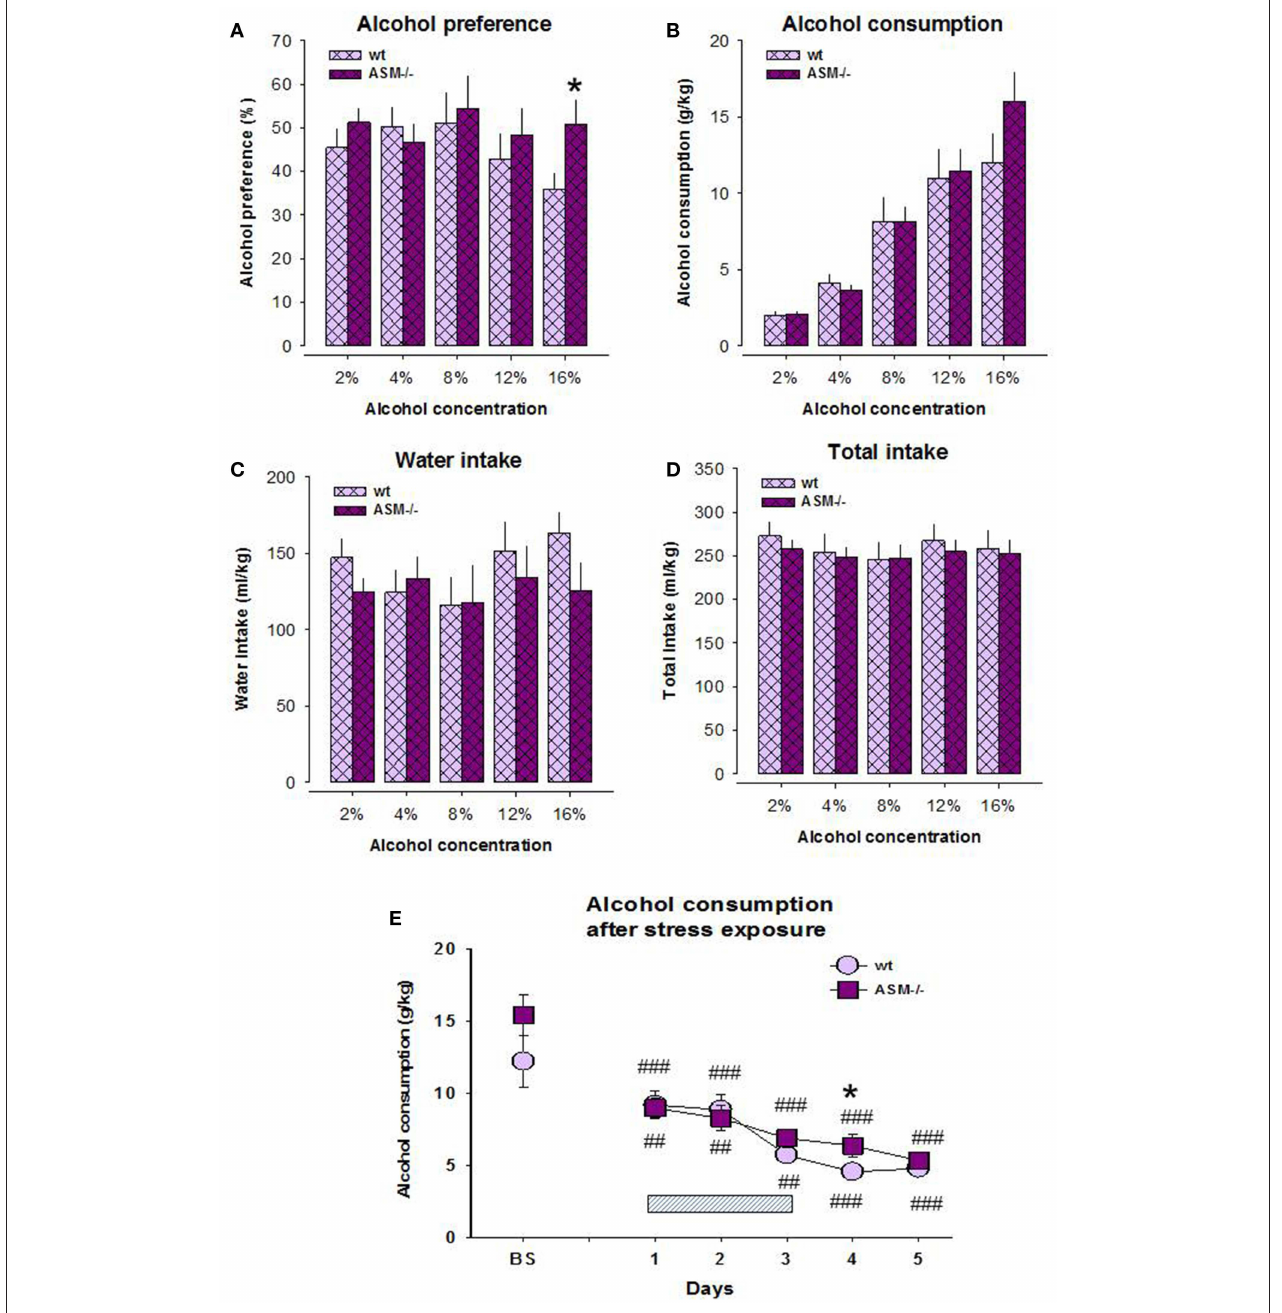
FIGURE 1 | Alcohol preference (A) and alcohol consumption (B) on the model of two-bottle free-choice drinking is enhanced in homozygous mice with acid sphingomyelinase deficiency (ASM − / − ) compared to wild type animals (wt). The levels of water intake (C) and total fluid intake (D) do not significantly differ between ASM − / − and wt mice. Stress (E) overwrites the differences in the drinking pattern of these animals. The hatched box indicates the time of stress exposure. The error bars show the mean ± SEM (* p < 0.05 vs. wt animals; ### p < 0.001, ## p < 0.01 vs. baseline, BS).